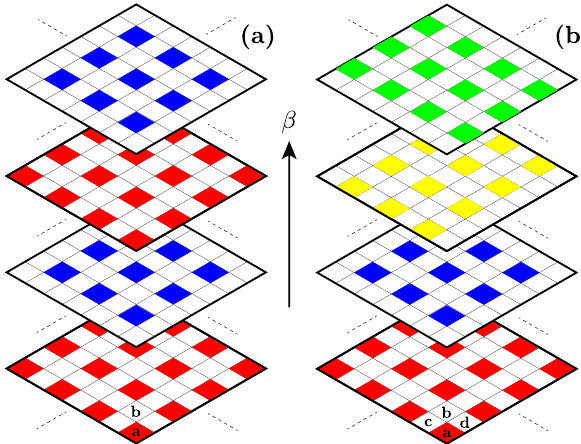
Figure 2: a - b (a) and a - b - c - d (b) checkerboard Trotter-Suzuki (TS) decomposition. Each plane corresponds to a given (imaginary) time